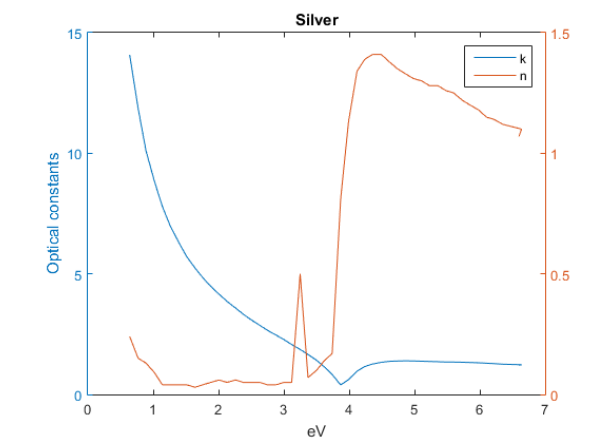
Figure 12. Metals’ optical functions.